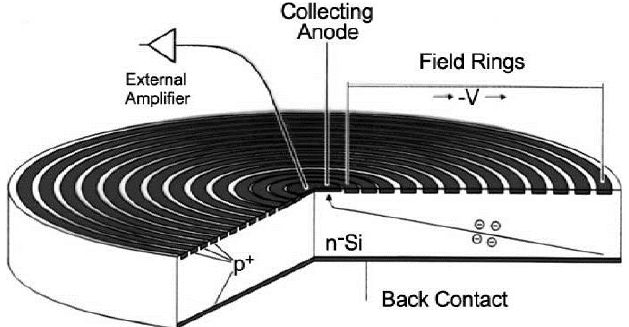
Figure 1. Schematic of the design and operation of a typical BSDD (bulk-silicon drift detector) designed as a radial silicon drift detector using planar patterning of the cathodes on the two sides of a bulk Si wafer. The back contact is used as light-entrance window and the drift field is set by the p + rings on the anode side of the wafer [19].